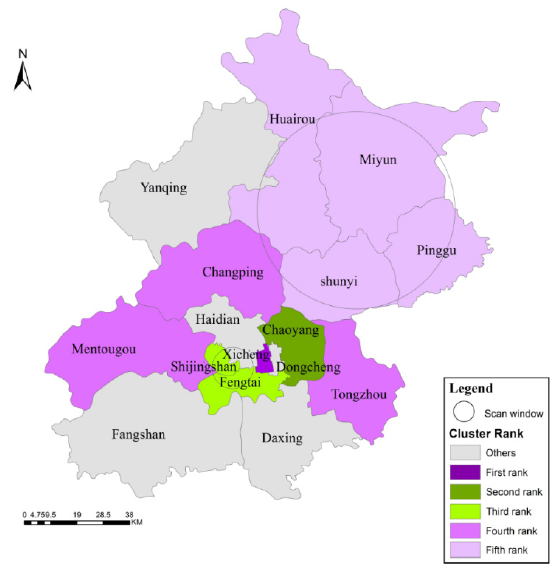
Figure 5. High and low IR spatial clusters in Beijing from 2009 to 2014.